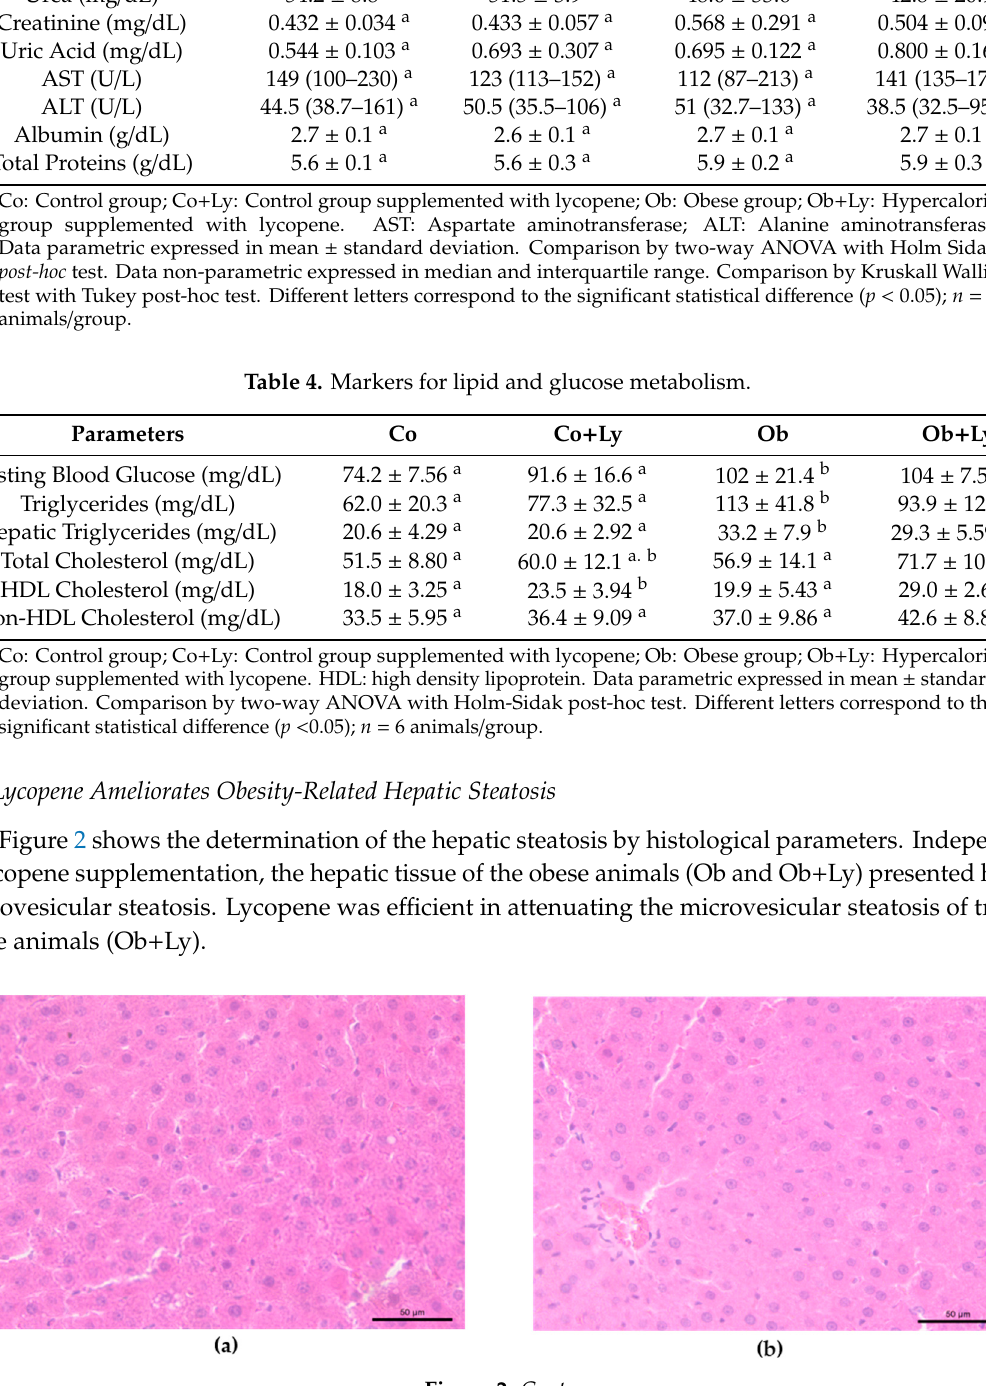
Figure 2. Determination of the hepatic steatosis by hepatic tissue histology stained with haematoxylin and eosin (H&E) ( a ) Illustrative picture (40× magnification) of the control group (Co); ( b ) illustrative picture (40× magnification) of the control group supplemented with lycopene group (Co+Ly); ( c ) illustrative picture (40× magnification) of the obese group (Ob); ( d ) illustrative picture (40× magnification) of the obese group supplemented with lycopene (Ob+Ly); ( e ) microvesicular steatosis (score); ( f ) macrovesicular steatosis (score). Presence of macro (red arrows) and microvesicular (green arrow) steatosis in obese groups. Data expressed in mean ± standard deviation. Comparison by Poasson distribution followed by the post-hoc test Wald multi-comparison. Different letters correspond to the significant statistical difference ( p < 0.05); n = 6 animals/group. 3.5. Lycopene Ameliorates TNF- α Levels in Hepatic Tissue In hepatic tissue, there was no difference between groups for the pro-inflammatory cytokine IL- 6. The Ob group presented the highest levels of TNF- α and the supplementation with lycopene in obese animals (Ob+Ly) was effective in the attenuation of cytokine levels (Figure 3).